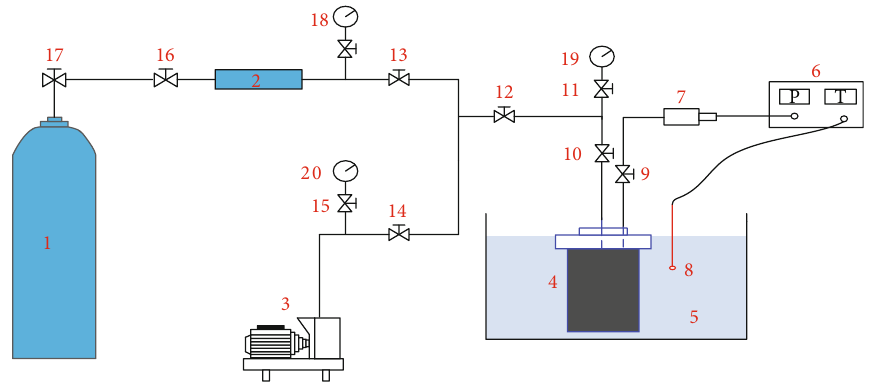
Figure 1: Schematic diagram of isothermal adsorption